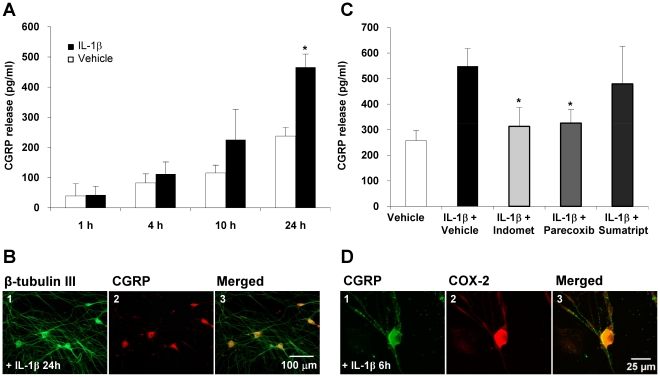
IL-1β induced CGRP release in TGN is dependent on COX-2 activity but not on 5-HT1B/D receptor activation.
A: IL-1β (10 ng/ml) but not vehicle stimulation for 1, 4, 10 (n = 4) or 24 hours (n = 12) resulted in significantly enhanced CGRP levels in the supernatant of cultured trigeminal ganglia cells at the 24 hrs time point (* p<0.05 vs. vehicle). Earlier time points did not show a significant difference between groups. CGRP release is shown as mean pg/ml ± SEM compared to baseline. Panel B shows a representative fluorescent photomicrograph of trigeminal ganglia cells exposed 24 hours to IL-1β (10 ng/ml). Cells were stained with a mouse β-tubulin III antibody, which specifically recognizes neuronal cells (1) and a rabbit CGRP antibody (2). β-tubulin III staining was visualized with an Alexa 488 donkey anti-mouse IgG antibody (green, panel 1). CGRP IgG was recognized by Alexa 594 donkey anti-rabbit antibody (red, panel 2). All CGRP expressing cells stained positive for β-tubulin III (orange, panel 3). C: For inhibition experiments TGC were exposed to either parecoxib (10 µM), sumatriptan ( µM), indomethacin (10 µM) or vehicle 45 min prior to 24 h stimulation with IL-1β (10 ng/ml). Incubation with parecoxib (n = 7) and indomethacin (n = 4) blocked CGRP release in the supernatant significantly compared to IL-1β + vehicle (n = 10). Sumatriptan had no effect in the same paradigm (n = 4). CGRP release is shown as mean pg/ml ± SEM compared to baseline. * p<0.05 compared to IL-1β + vehicle. D: Immunofluorescence staining shows that CGRP is co-expressed with COX-2 in trigeminal ganglia neurons (n = 3). Cultured trigeminal ganglia cells were exposed to IL-1β (10 ng/ml) for 6 hrs. Cells were stained with an Alexa Fluor 488 donkey anti-mouse IgG labeled rabbit anti-CGRP serum (green, panel 1) and with a rabbit anti-COX-2 antibody, which was recognized by an Alexa Fluor 594 labeled secondary donkey anti-rabbit antibody (red, panel 2). Double stained cells appear orange (panel 3). All CGRP synthesizing cells also stained positive for COX-2. Additionally COX-2 was expressed in glial cells not staining positive for CGRP.